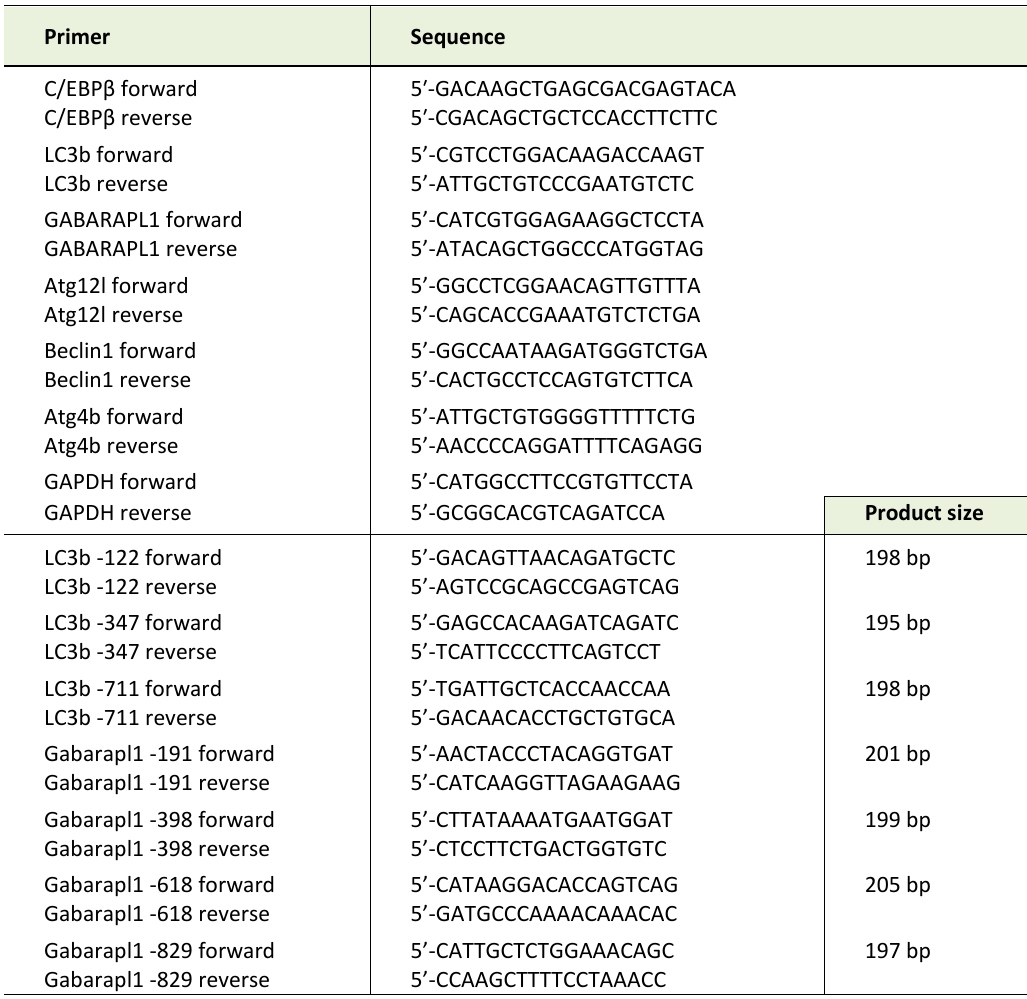
TABLE 1. PCR primers used in this